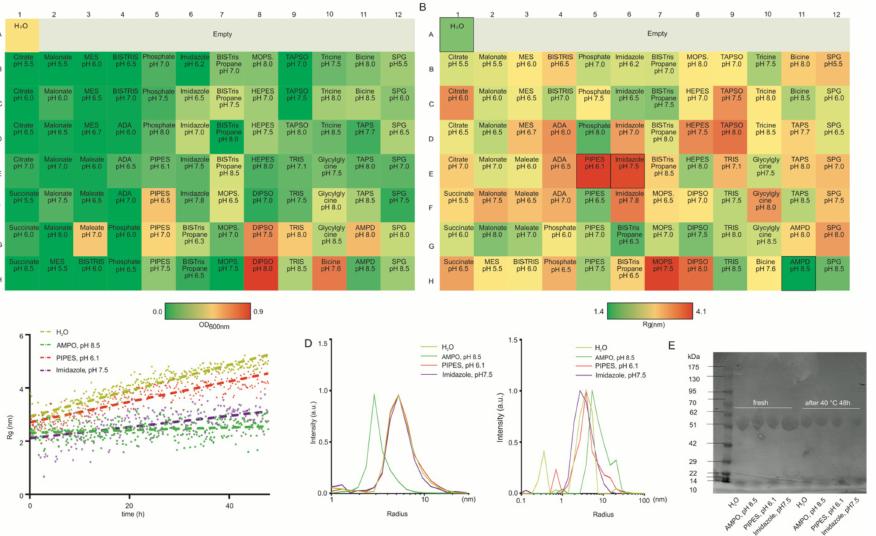
Figure 4. ( A ) A microplate assay for measuring OD 600 screening of the antibody fragment (5 mg/mL) colored by value (>0.5 means aggregation). ( B ) SAXS-based screening of the antibody fragment (5 mg/mL) colored by the value of the radius of gyration R g . ( C ) Changes in Rg value were obtained for the antibody fragment at extreme formulations with 40 ◦ C. ( D ) Mean radii distribution of the antibody fragment at extreme formulations with 40 ◦ C before and after 48 h measured by DLS. ( E ) SDS-polyacrylamide gel electrophoresis (SDS-PAGE) of the antibody fragment was incubated at extreme formulations at 40 ◦ C before and after 48